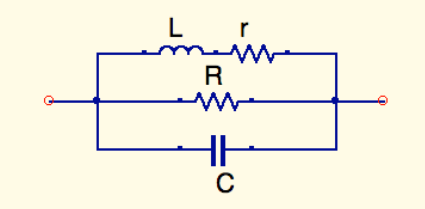
Figure 2. Resonant filter